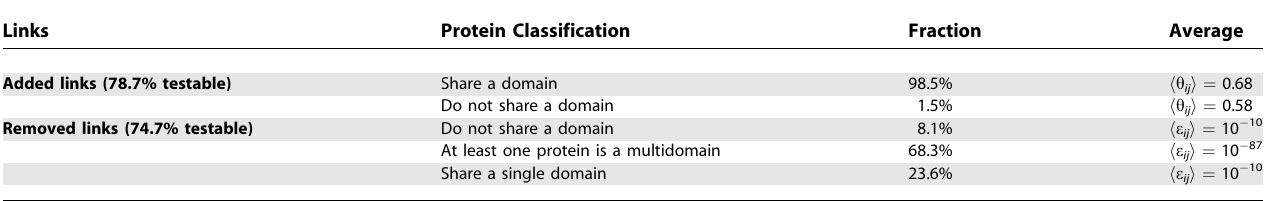
Table 1. Comparison to the Pfam Database Links Protein Classification Fraction